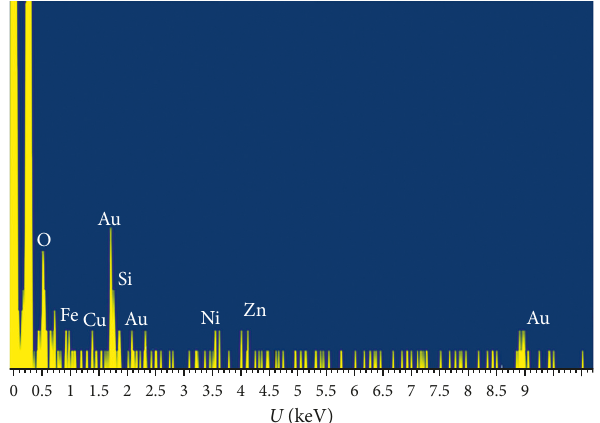
Figure 2: The X-ray fluorescence spectrum of the Si composite